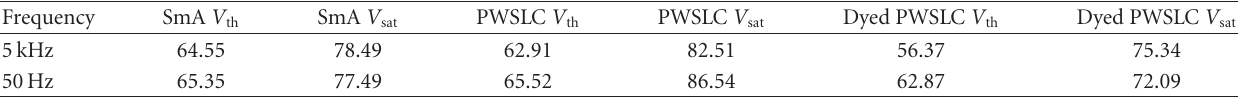
Table 2: The summary of static-response measurements of pure SmA and PWSLC with/without dye at EHDI and FC-HT